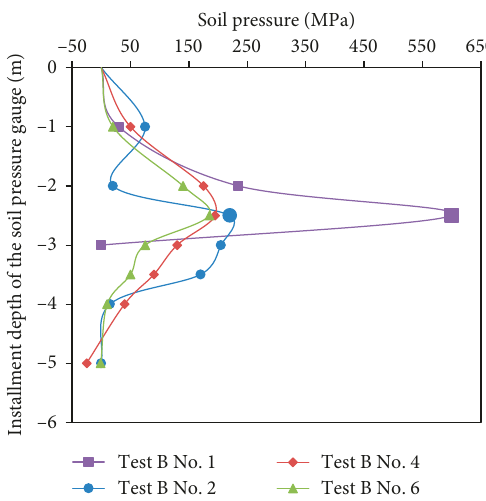
Figure 8: Variation of horizontal thrust with loading